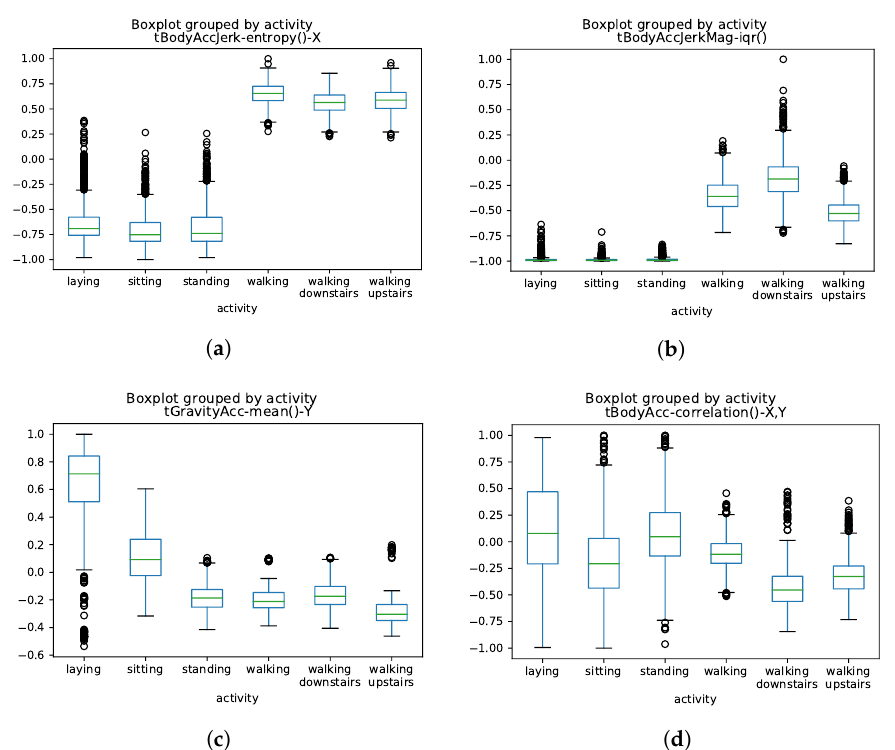
Figure 1. Boxplots for four features of the dataset grouped by activity. ( a ) Entropy of the x -axis jerk signal of the body acceleration. ( b ) Interquartile range of the jerk signal magnitude of the body acceleration. ( c ) Mean of the y -axis signal of the gravity acceleration. ( d ) Correlation between x - and y -axis signals of the body acceleration.